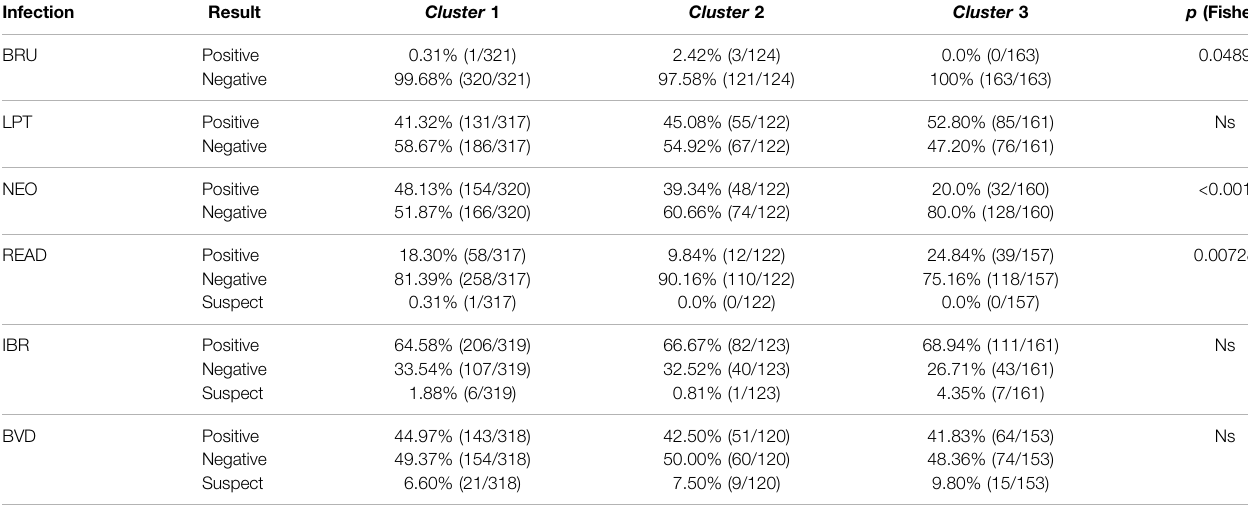
TABLE 8 | Prevalence of antibodies against microorganisms that cause brucellosis, leptospirosis, neosporosis, leukosis, rhinotracheitis, and viral diarrhea in Curraleiro Pé- Duro cattle by genetic clusters. Infection